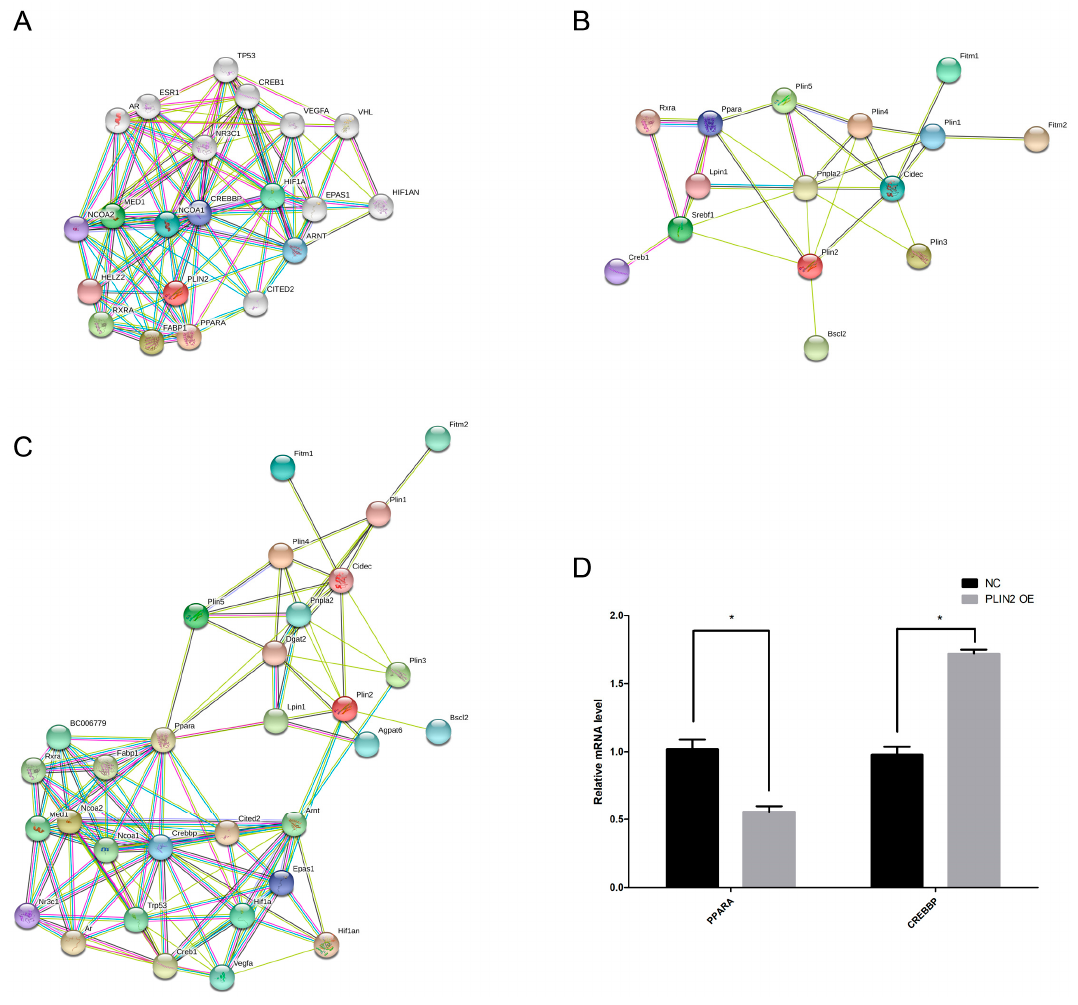
Figure 6. Protein interaction network analysis. ( A ) Analysis of proteins that interact with PLIN2. ( B ) Analysis of the interaction among PLIN2 and genes related to lipid droplet formation. ( C ) Comprehensive analysis of protein interaction networks. ( D ) Detection of mRNA expression levels of PPAR α and CREBBP (CREB binding protein) by qRT-PCR with the overexpression of PLIN2 . *, p < 0.05.